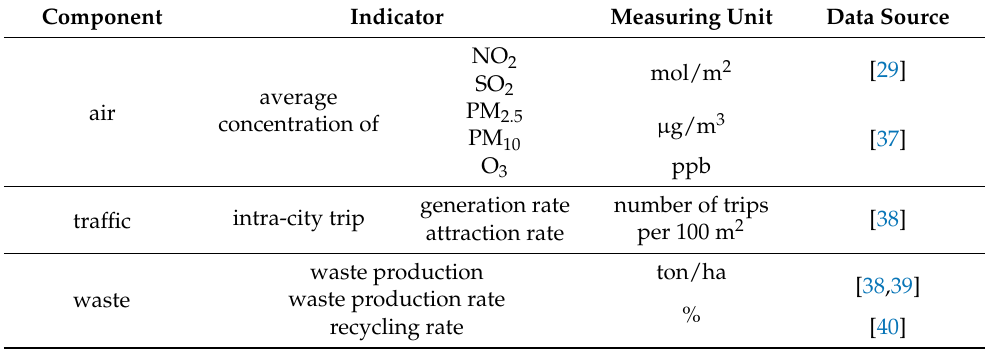
Table 1. Indicators for monitoring the environmental pressures caused by the impacts of human activities on the ecosystem of Tehran.